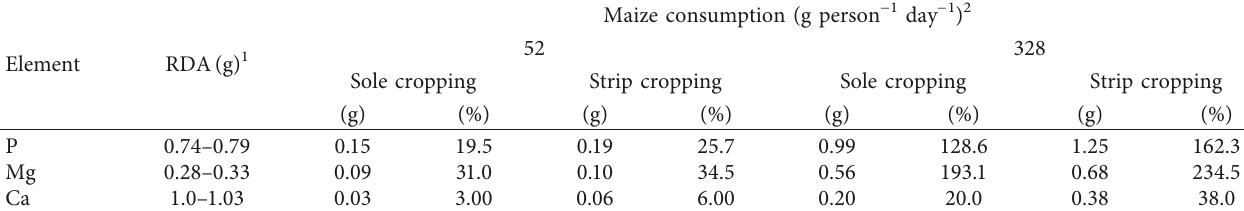
Figure 3: The influence of cropping method and row position in the strip on macronutrients uptake by maize grain (in kg · ha − 1 ) (mean for 2008–2010). NB, row next to barley; IN, inner row; NC, row next to common bean. Table 5: The amount of nutrients supplied by maize grain at different levels of human consumption (in g) and the percentage coverage of the demand for these